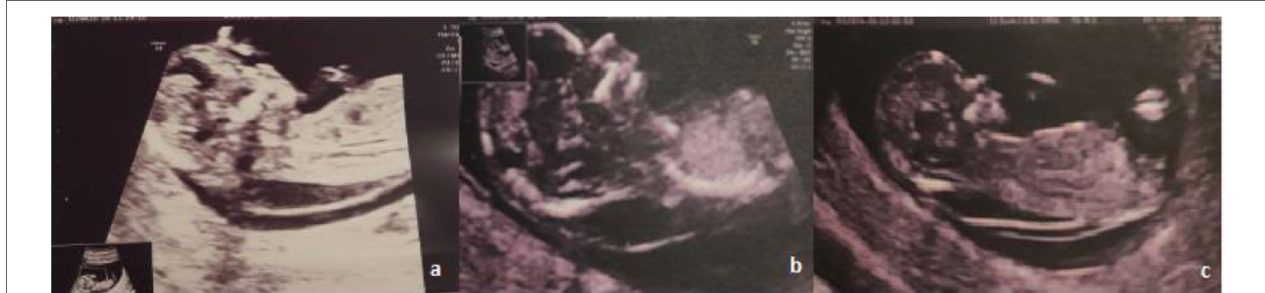
FIgURe 1 | Ultrasonographic images of the